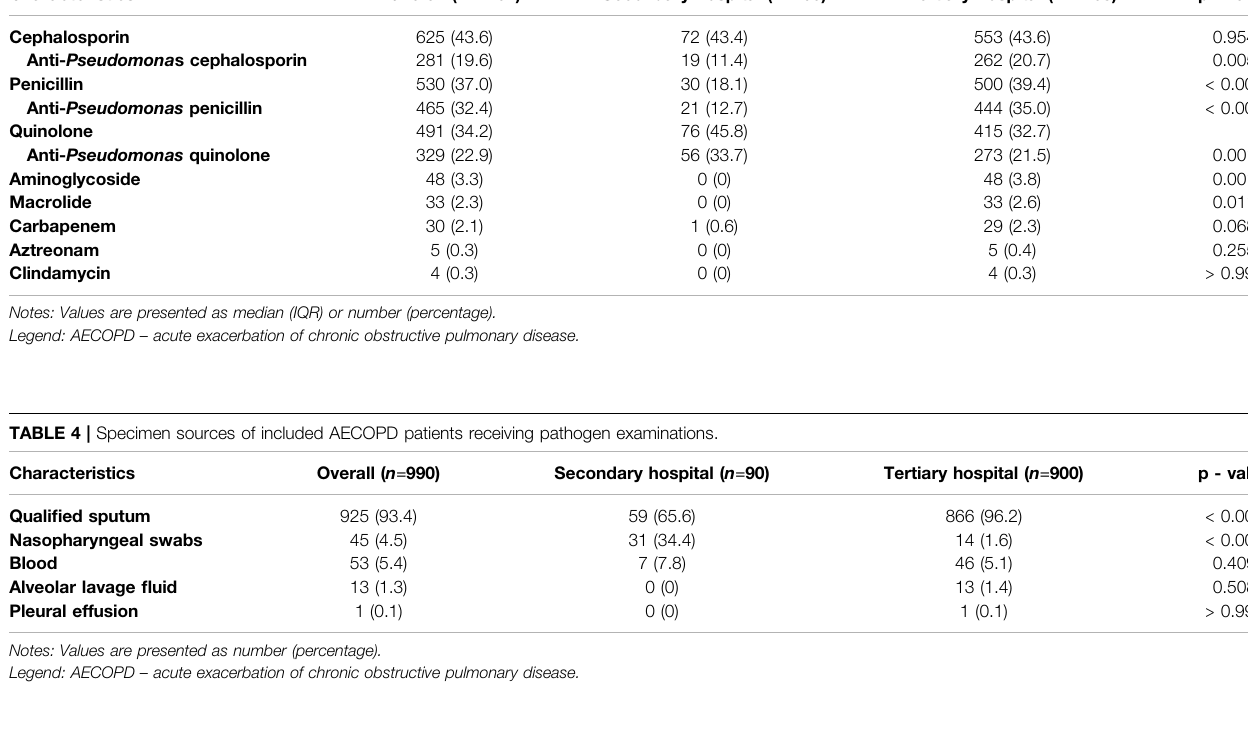
TABLE 5 | Distribution of positive bacterial pathogens in included AECOPD patients with bacterial culture results.